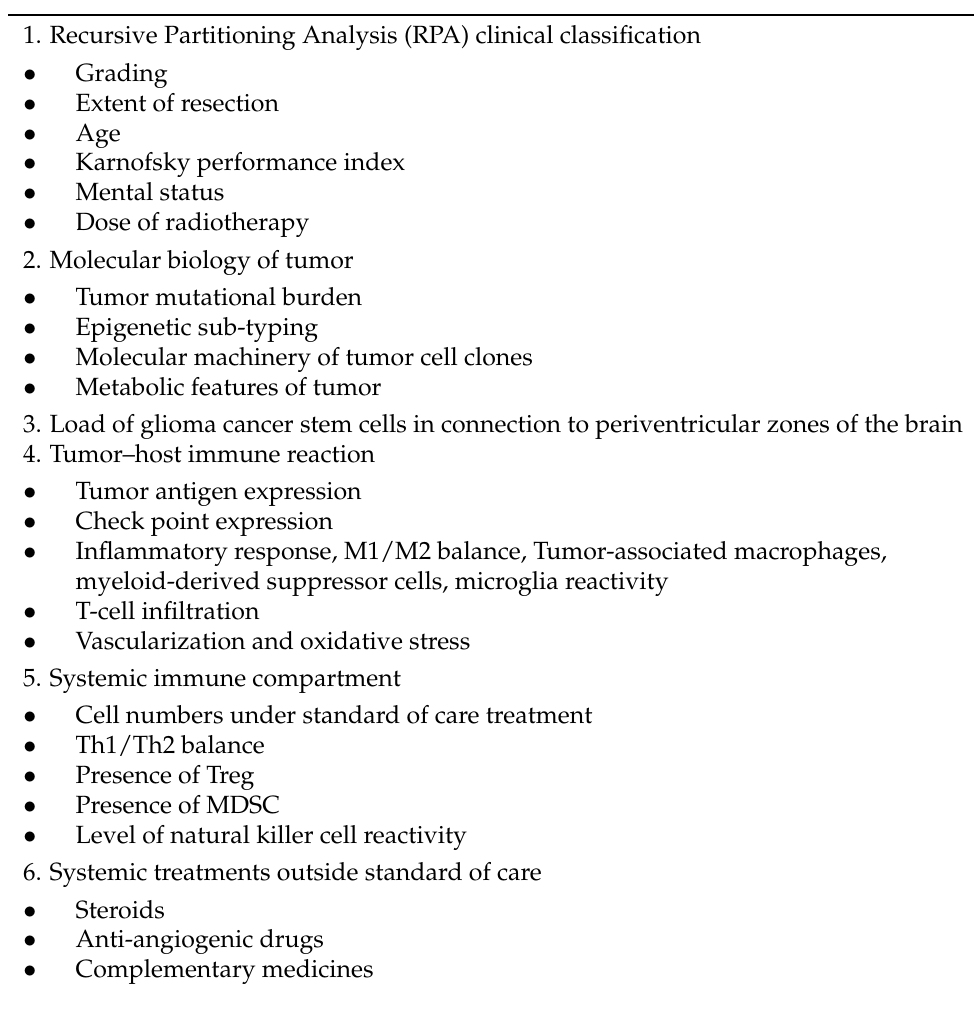
Table 1. Risk factors for stratification in randomization or for in/exclusion